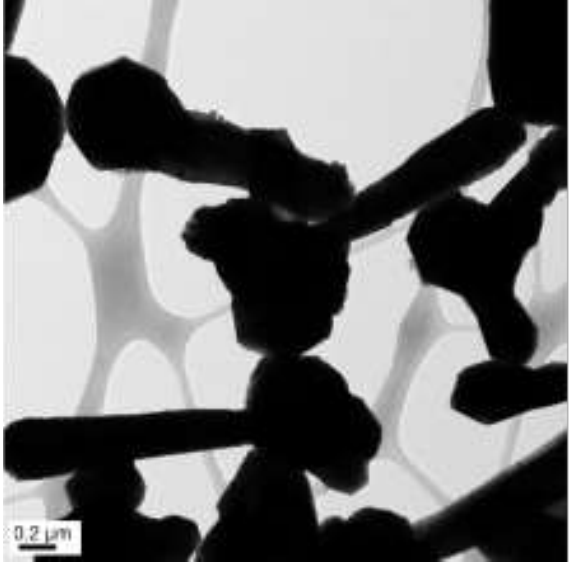
Figure 9. TEM images of copper nanowires with 50 µL of EDA (scale bar 0.2 µm).